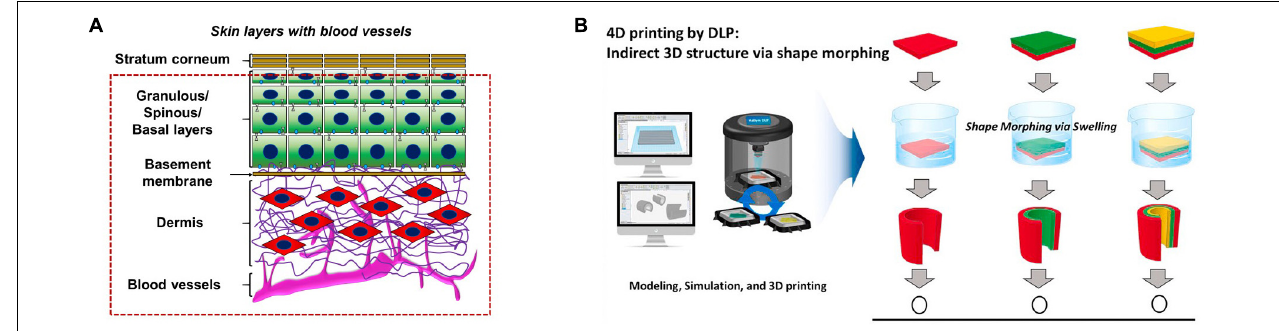
FIGURE 3 | New conceptual printing methods. (A) Layered printing to achieve vascularized skin. (B) The advantage of digital light processing 4D printing is that on the basis of digital light processing 3D printing, one material is used to manufacture structures with multiple curvatures. Reprinted with the permission from Elsevier (Kim et al., 2020; Su et al., 2020). With the permission from Elsevier. Reprinted from Barros et al. (2020) and Kim et al. (2020).